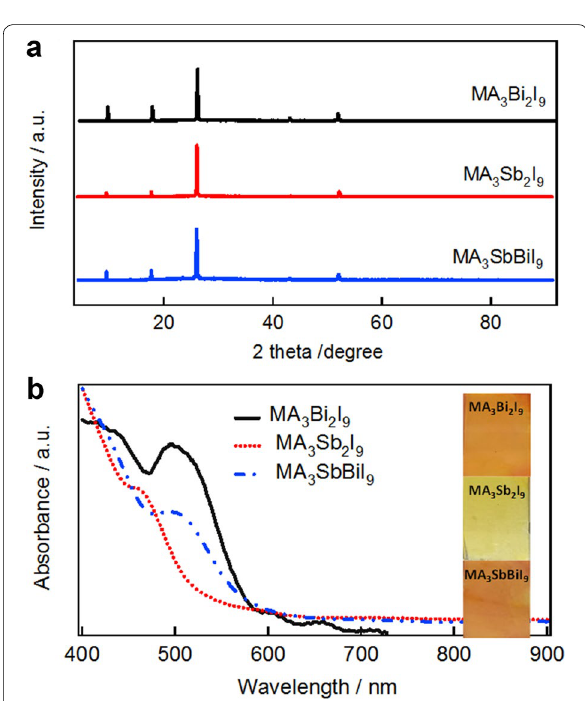
Fig. 2 XRD patterns ( a ) and UV–vis absorption spectra ( b ) of grown solution processed (CH 3 NH 3 ) 3 Bi 2 I 9 , (CH 3 NH 3 ) 3 Sb 2 I 9 and